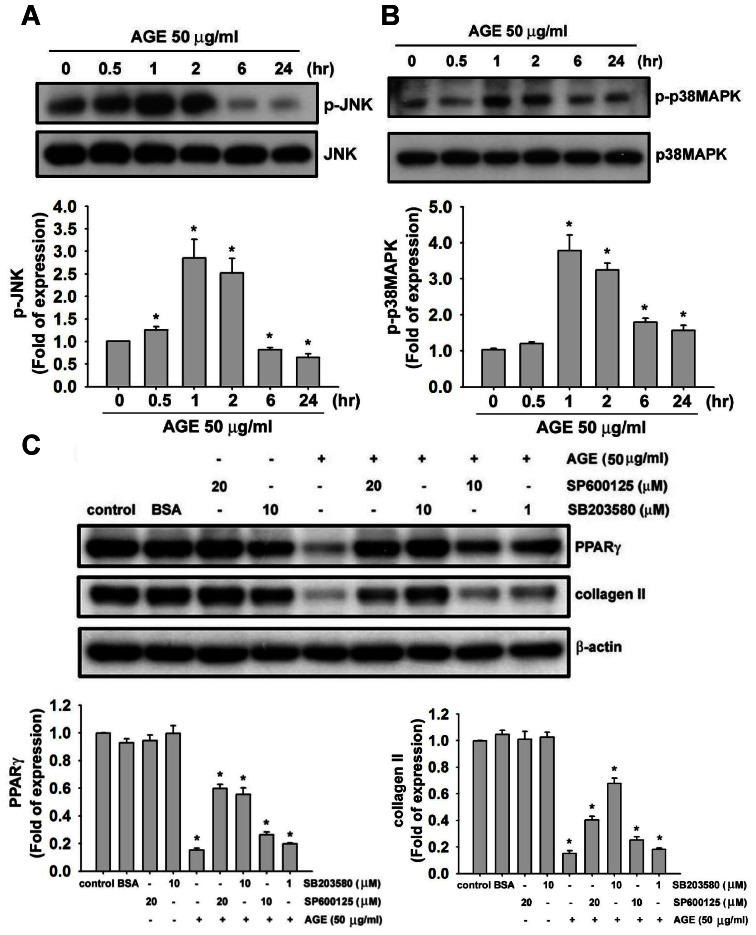
Involvement of MAPK signaling in AGEs-induced PPARγ down-regulation and reduction of collagen II expression.Human OA chondrocytes (1×106/ml) were incubated with AGEs (50 µg/ml) for 0.5–24 hours (A, B) or 24 hours (C). The phosphorylations of JNK (A) and p38MAPK (B) were determined by Western blotting. In C, chondrocytes were pretreated with SP600125 (10 and 20 µM) or SB203580 (1 and 10 µM) for 1 hour followed by treatment with AGEs for 24 hours. Protein expressions of PPARγ and collagen II was determined by Western blotting. Densitometric analysis for p-JNK, p-p38MAPK, PPARγ, and collagen II levels corrected to JNK, p38MAPK, β-actin, and β-actin, respectively, is shown. All data are presented as mean ± SEM for three independent experiments. *: P<0.05 versus control. #: P<0.05 versus AGEs alone.